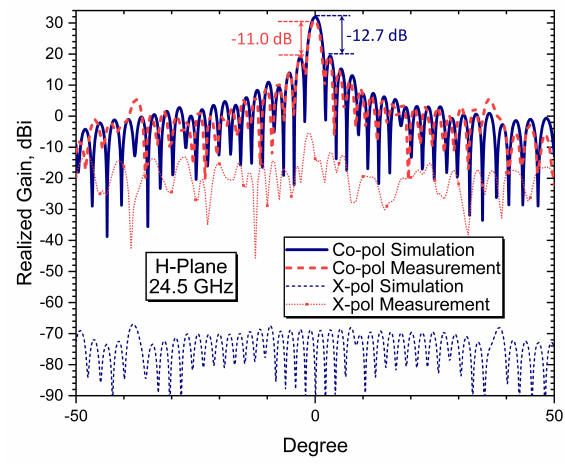
FIGURE 7. Simulated and measured H-plane radiation patterns of the antenna at 24.5 GHz.